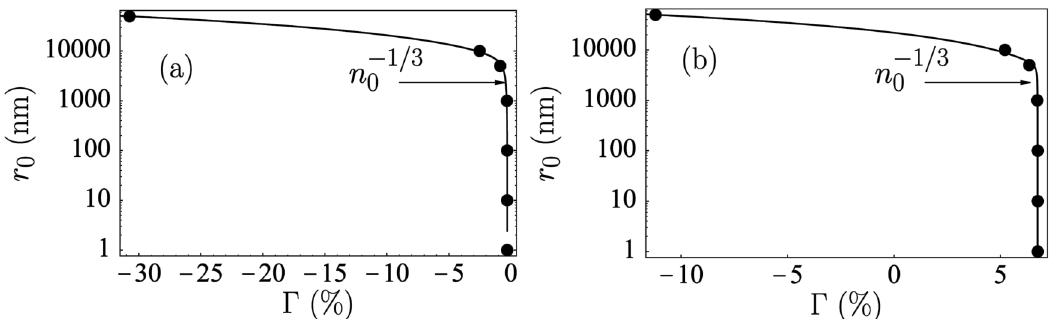
FIG. 4. Energy conservation relative error (cid:3) versus cutoff parameter r for (a) an initially cold spherical electron distribution with 0 (cid:1) 0 , radius a (cid:1) a (cid:1) a (cid:1) 24 (cid:4) m , energy spread (cid:5) (cid:1) 0 , divergence x 0 parameters: Charge Q (cid:1) 1 nC , beam energy E 0 1 2 3 ’ 1 : 74 (cid:4) m , and (b) a moving ellipsoidal charge distribution with identical parameters typical distance between macroparticles n (cid:6) 1 = 3 0 (cid:1) 1 : 12 MeV and a (cid:1) 10 : 92 (cid:4) m , corresponding to a cold spherical electron distribution in its rest frame, i.e., a 0 except for E 0 3 (cid:1) a 0 (cid:1) 24 (cid:4) m ( a 0 (cid:1) (cid:7) a 0 a ). The latter allows for a direct comparison with analytical 0 3 2 3 3